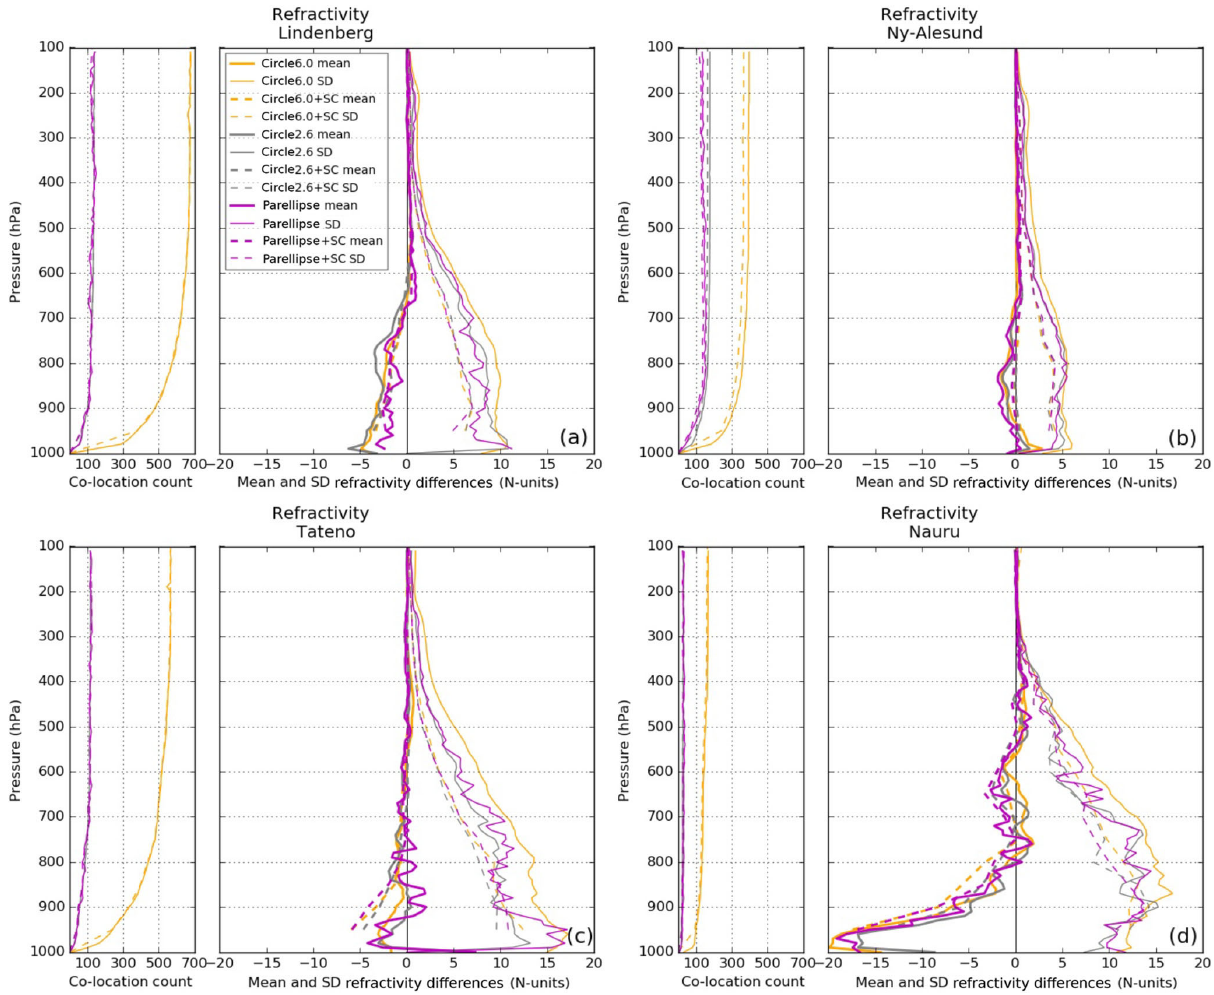
Figure A1. RO–RS refractivity mean (thick) and SD (thin) difference profiles for the six co-location methods at Lindenberg (a) , Ny- Ålesund (b) , Tateno (c) , and Nauru (d) . The number of co-located RO–RS pairs are given on the left side of each panel (without the sampling correction: solid; with the sampling correction: dashed). The color schemes are the same as Figs. 4–7 and are given in the legend in (a) where SC stands for sampling